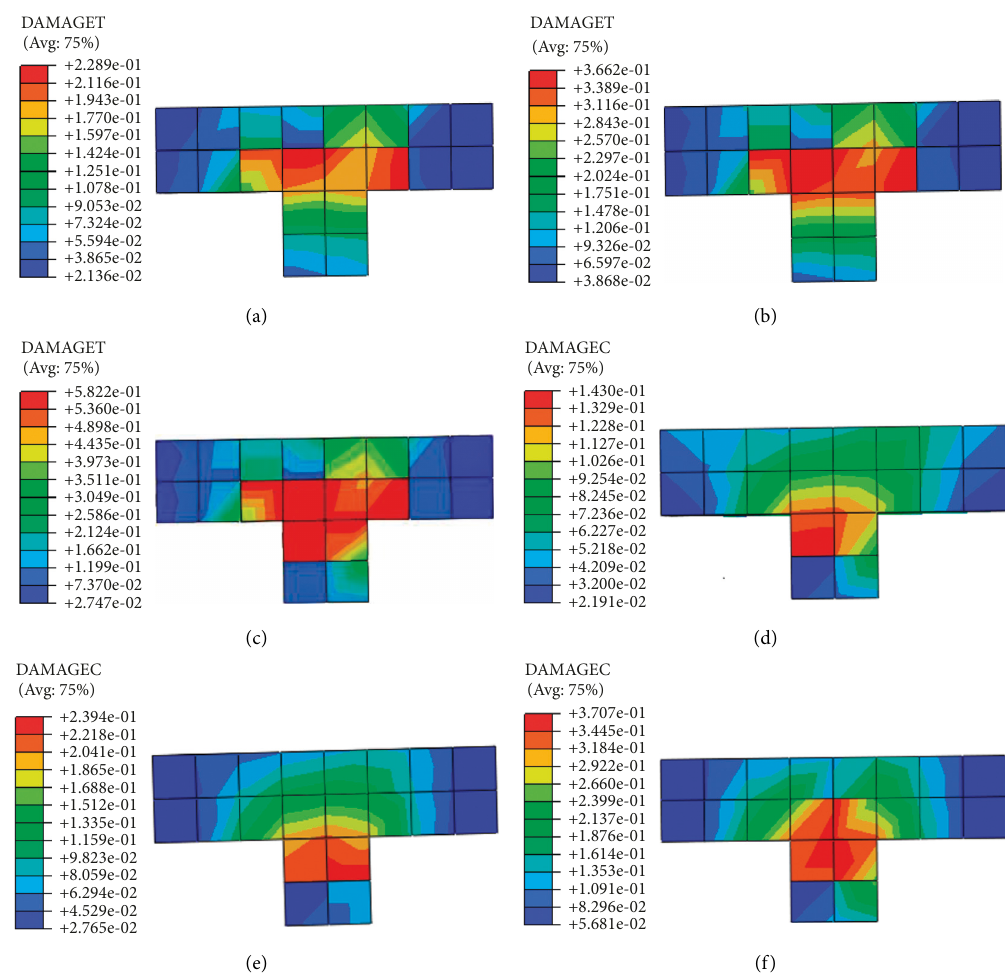
Figure 14: Damage contours under the loading of a positive temperature gradient. Tensile damage: (a) 30 ° C/m, (b) 60 ° C/m, and (c) 90 ° C/m. Compression damage: (d) 30 ° C/m, (e) 60 ° C/m, and (f) 90 ° C/m.